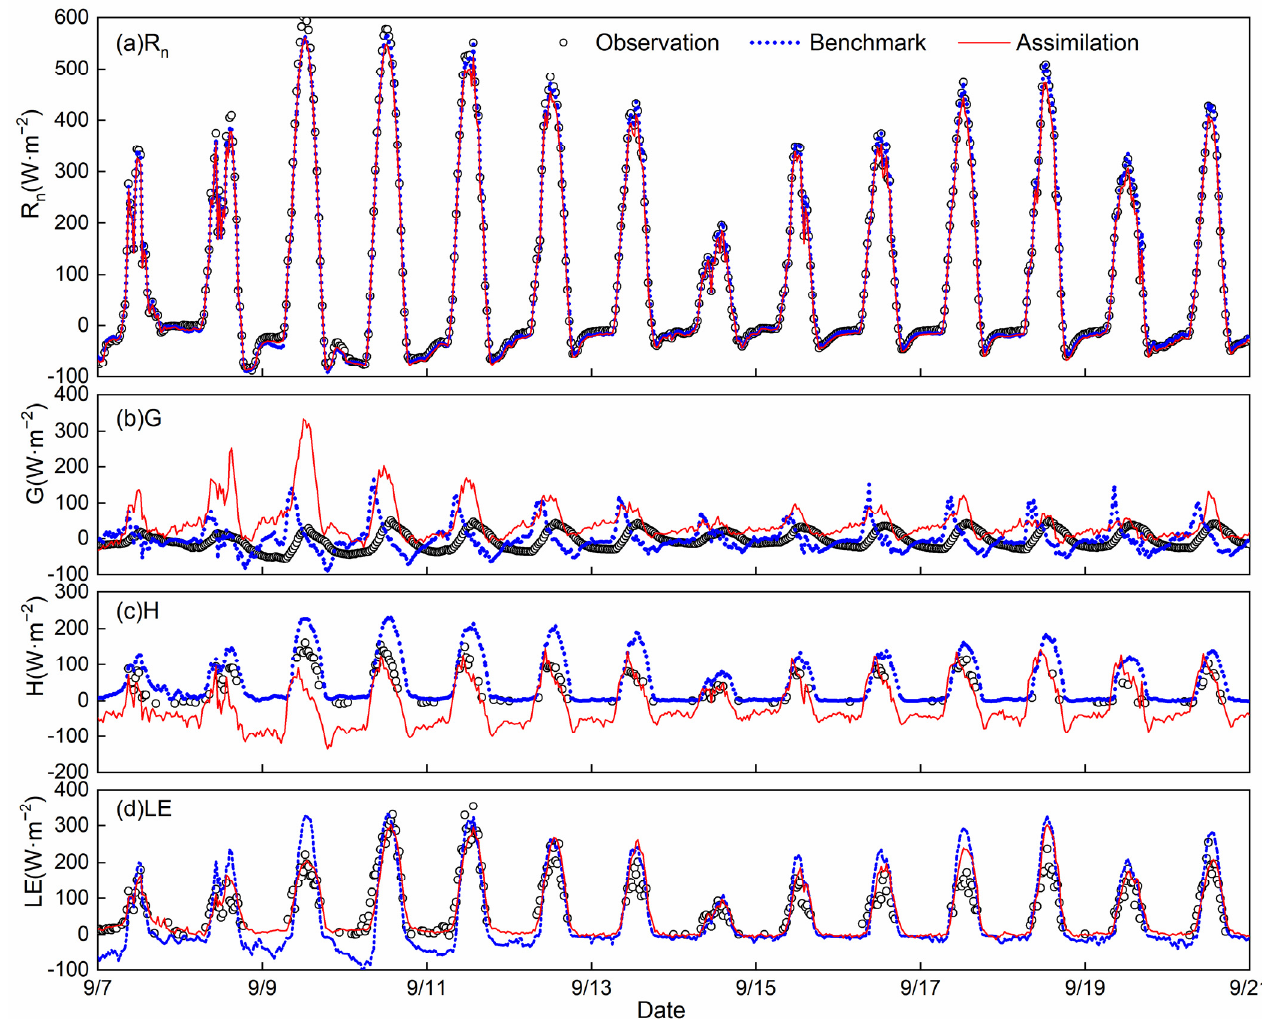
Figure 10. Comparison of surface flux assimilation results and benchmark run with ground measurements during maize growing season from 7 September 2006 to 20 September 2006.